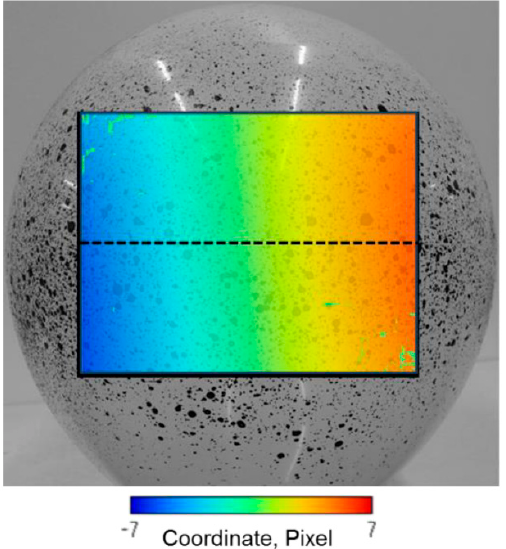
Figure 4. Black dotted balloon deformation.